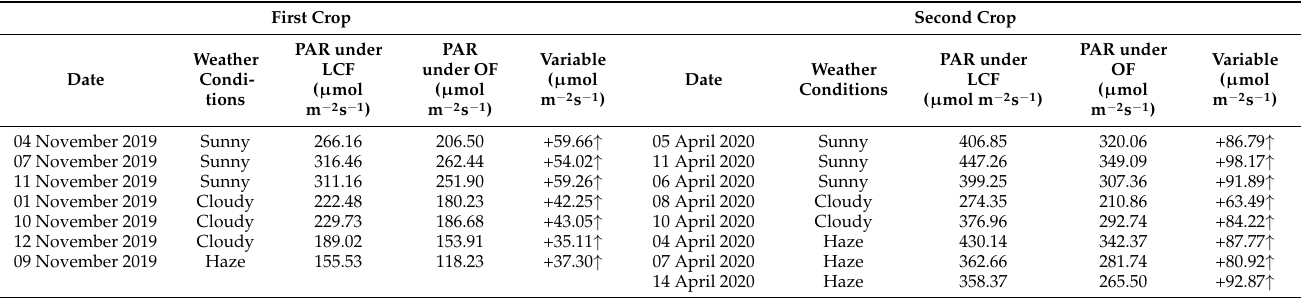
Table 4. Effects of different crops and different weather on photosynthetic effective radiation under light conversion film (LCF) and ordinary film (OF)